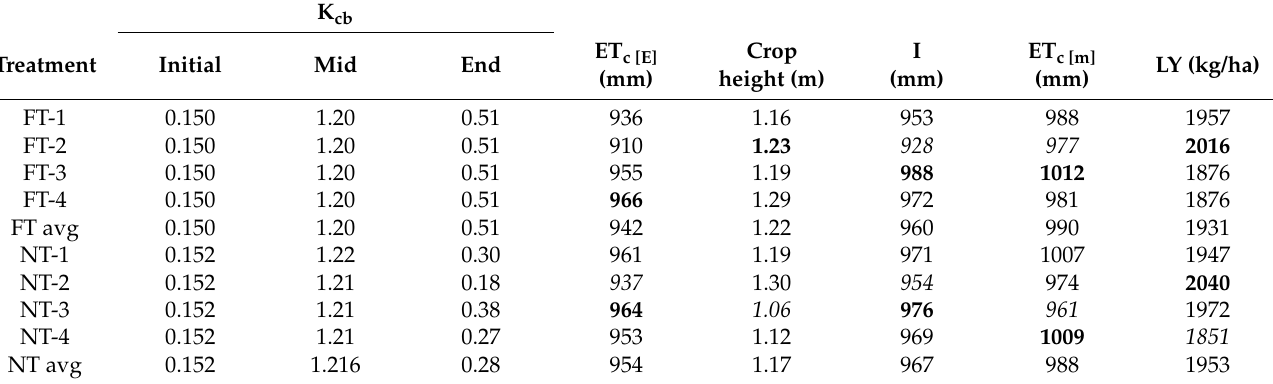
Table 5. Estimated treatment plot Kcb for initial, mid-season, and end-of-season growth stages and estimated total crop evapotranspiration (ET c [E] ) through 1 October (DOY 274); measured maximum